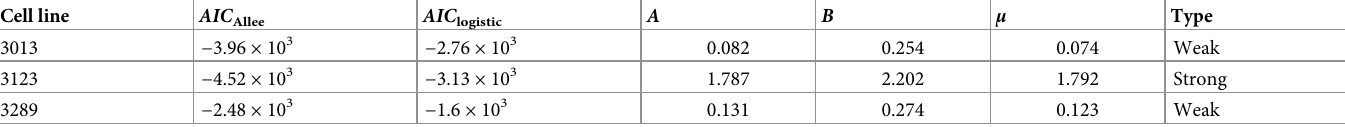
Table 2. Details of model fit to data. The parameter values ( A , B , μ ) refer to the optimal fit for the Allee model. For a visual comparison see Fig 5. Cell line AIC